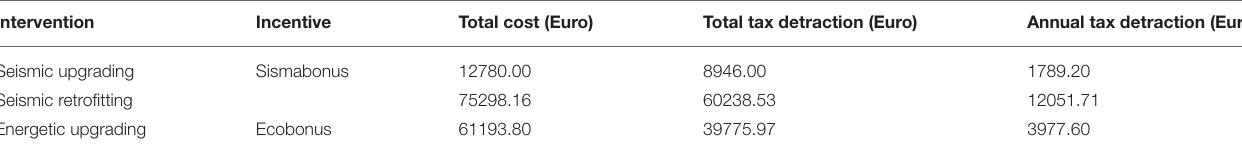
TABLE 12 | Italian Government incentives for seismic and energetic interventions.